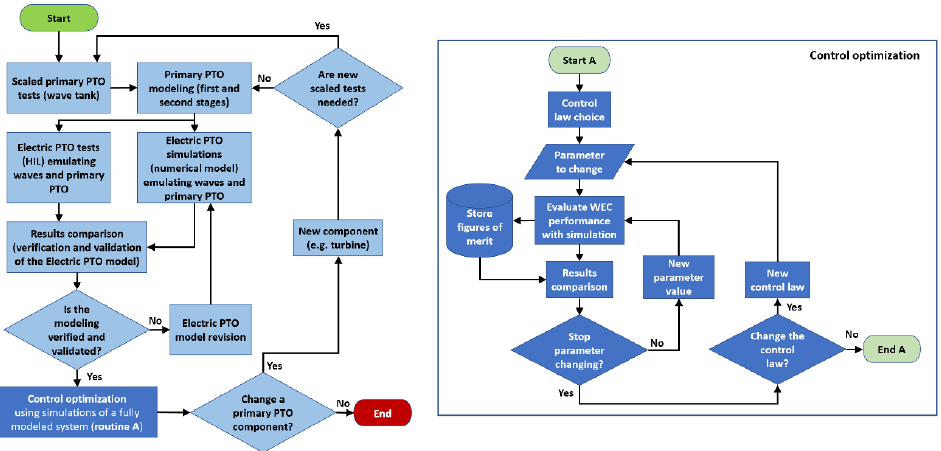
Figure 1. Flowchart of the procedure to set and optimize the control of a WEC at the early development stages.